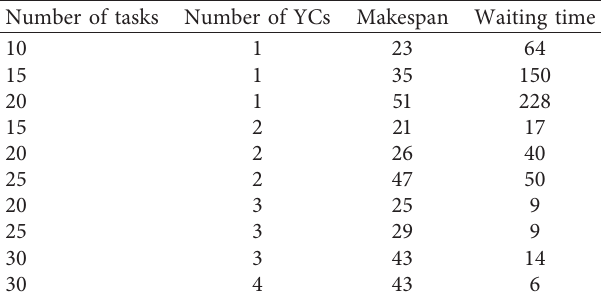
Table 4: Sensitivity analysis of key parameters.